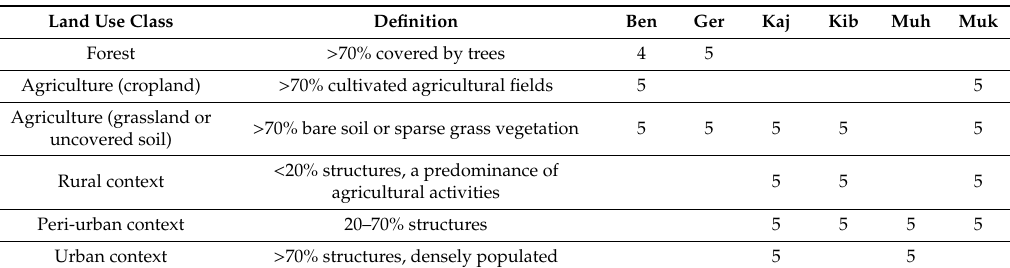
Table 3. Land use classes and representation in datasets (Bentelo, Gerleve, Kajiado, Kibonde, Muhoza, Mukingo). Digits indicate the number of image pairs used for the experiment. Percentage, as outlined in the definition, refers to pixel representing specific land